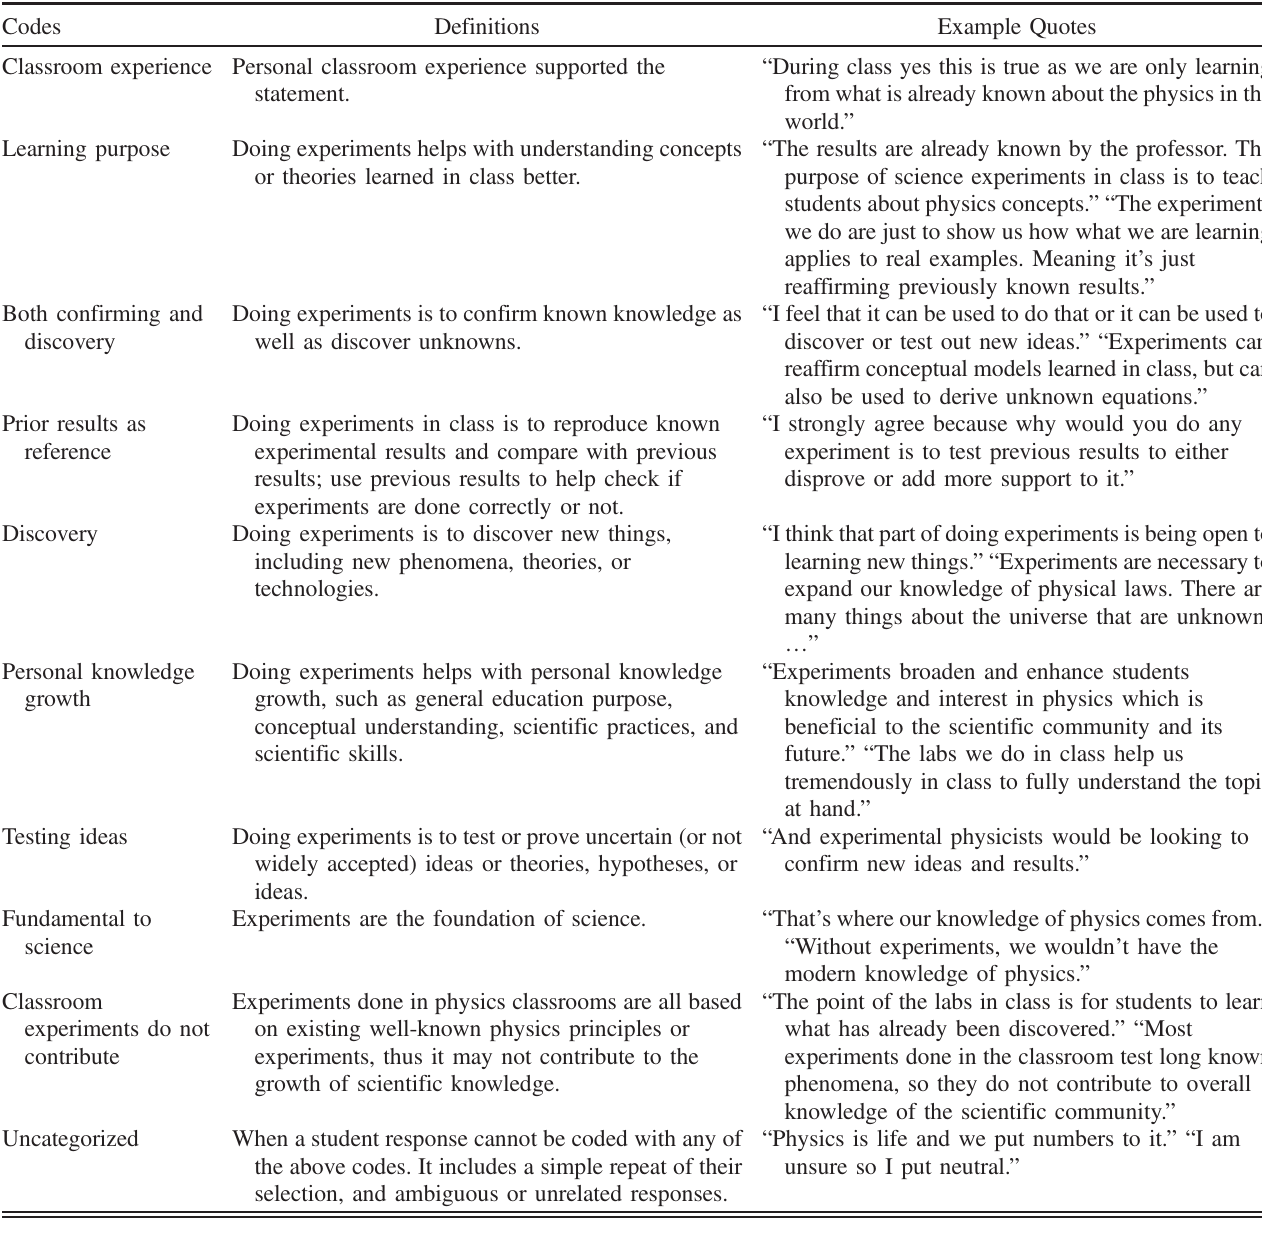
TABLE II. Code definitions and example quotes regarding students ’ responses to Q1a “ The primary purpose of doing physics experiments is to confirm previously known results ” and Q1b “ Physics experiments contribute to the growth of scientific knowledge.